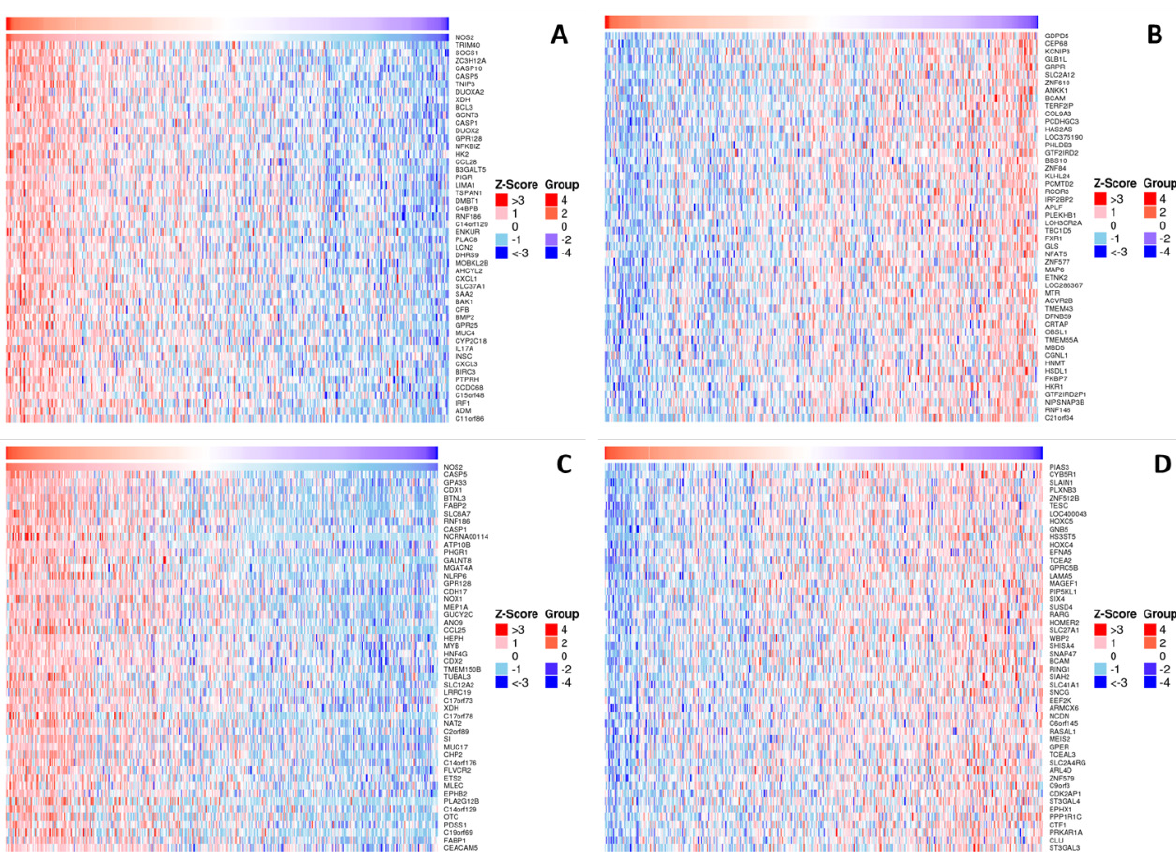
Figure 4: Heatmap of iNOS/NOS2 and co-expressed genes(A: Positive co-expressed genes in colorectal cancer; B: negative co-expressed genes in colorectal cancer; C:positive expressed genes in gastric cancer; D: negative co-expressed genes in gastric